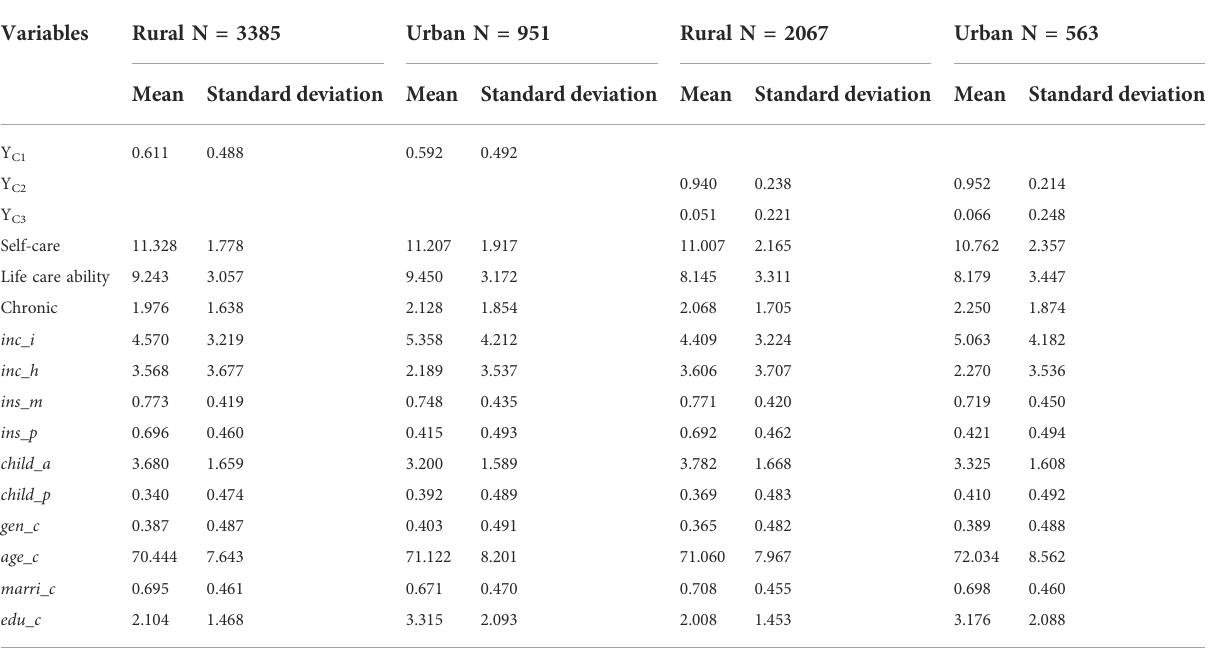
TABLE 4 Statistics of main variables of urban and rural samples